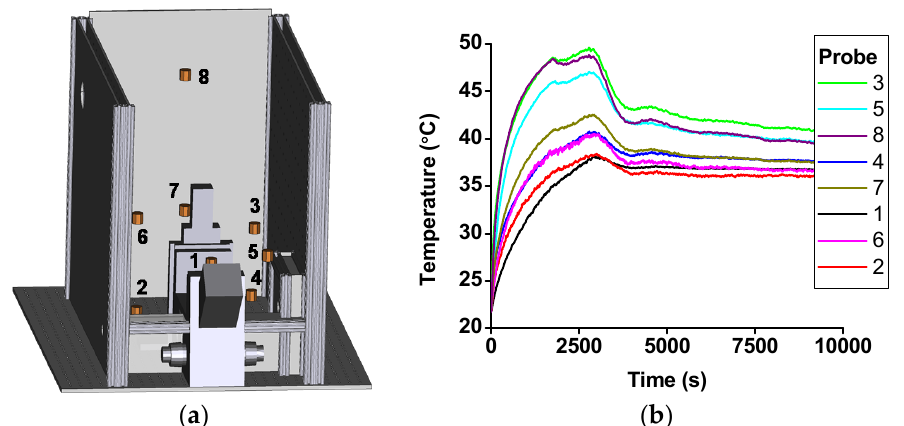
Figure 3. Enclosure temperature with the heater temperature sensor attached directly to the objective of a microscope. ( a ) Thermocouples were placed at 8 locations in an inverted microscope enclosure (same as Figure 1a). Probe 1 was attached, along with the heater feedback probe, directly to metal housing of the objective. All the other probes were in the air. Probes 2 and 6 were on the left side of the microscope (5 cm from the outgoing return air baffle panel), probes 3, 4, and 5 were on the right side of the microscope (10 cm from the incoming supply air baffle panel), and probes 1, 7, and 8 were in the center. Probes 1, 3, 5, 6, and 7 were all at a similar height from the table as the objective (30 cm), while probes 2 and 4 were closer to the table (15 cm), and probe 8 was the farther from the table (60 cm). Probes 1, 2, and 5 were 20 cm from the front of the enclosure, while probes 3, 5, and 6 were about 40 cm, and probes 7 and 8 were 65 cm (near the back). (Note: In this figure, the microscope stage, brightfield illumination optics, and top and front panels are not illustrated.) ( b ) Temperature readings were collected after the setpoint of the heater was changed to 37 °C. The probes closer to the incoming supply air baffle panel experienced higher temperatures than those shielded by the microscope. In addition, while equilibrating, the air temperature went significantly above 37 °C.